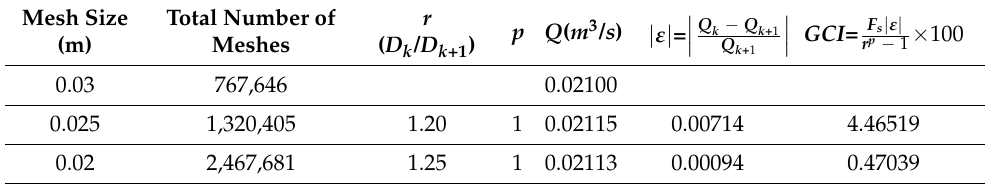
Table 2. GCI calculation